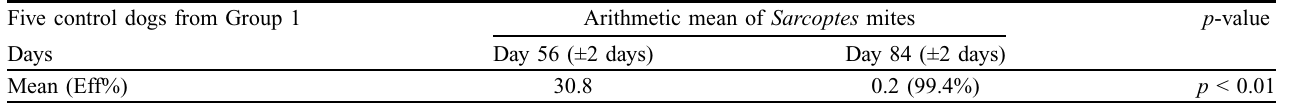
Table 5. Efficacy of treatment on five control dogs at Day 56 (based on arithmetic means). Five control dogs from Group 1